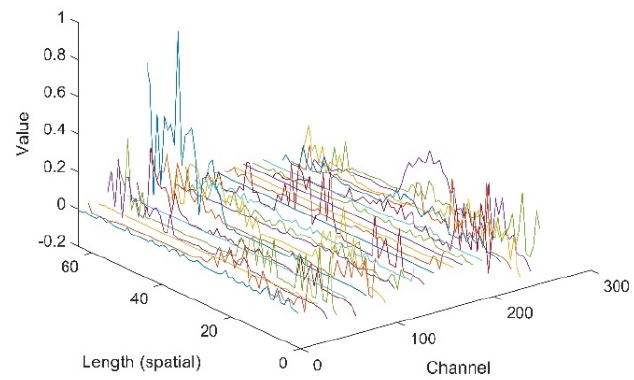
Figure 8. The features weighted by the attention unit.